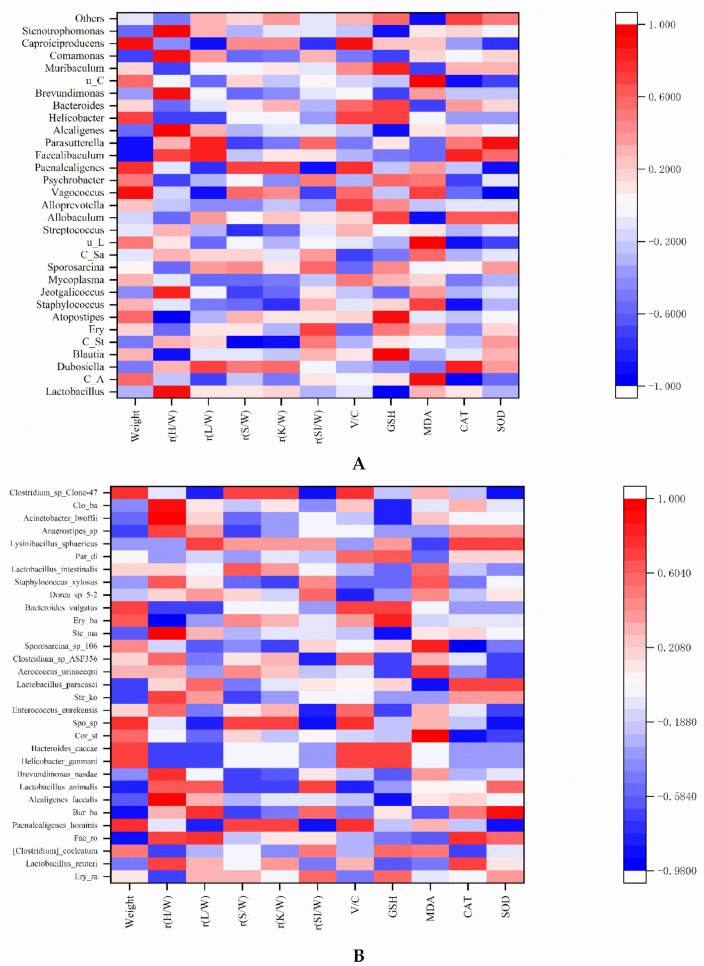
Figure 7. Heatmaps of Spearman’s correlation coefficient of relative abundance microbial composition data ( A ) genus level, ( B ) species level with parameters related to the characteristics of mice’s body characteristics and antioxidant ability of mice’s serum. The full names and abbreviations are as follows, and the